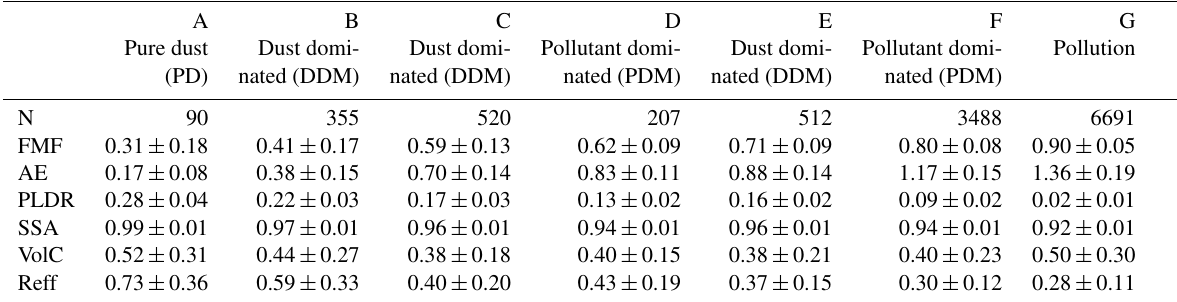
Figure 3. Flow chart of the aerosol classification based on the dust ratio R d derived using PLDR at 1020nm and the 1020nm SSAs that are inferred from the inversion of AERONET observations. Table 2. Average values of AERONET-derived aerosol parameters for the sectors identified in Fig. 5: FMF, AOD-related Ångström exponent for the wavelength pair 440 and 870nm (AE), PLDR at 1020nm, SSA at 1020nm, total volume concentration (VolC), effective radius (Reff), and the volume median radius (VMR). For comparison, Lee et al. (2010) classify categories A and B as dust, categories C and D as mixed, and categories E, F, and G as